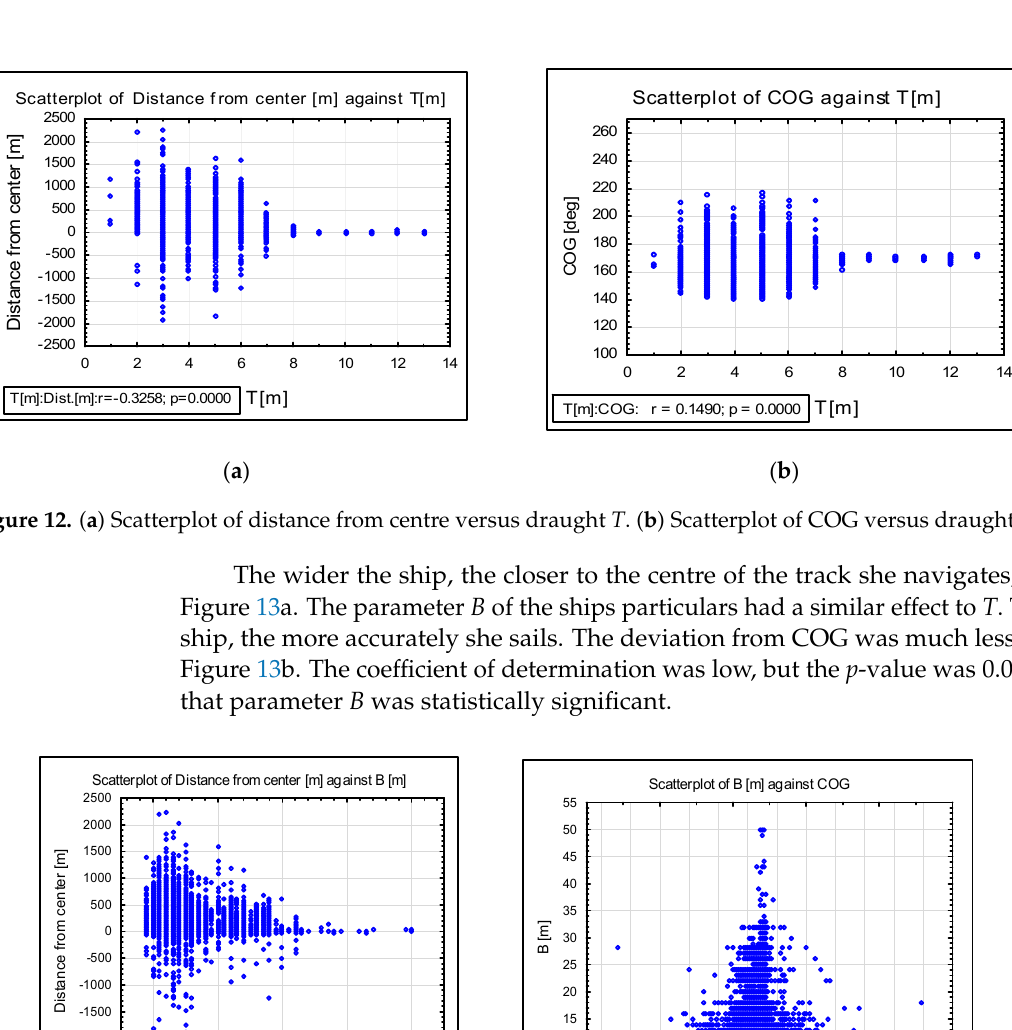
( b ) Figure 11. ( a ) Mean versus distance to 10 m isobaths D 10m , R 2 = 0.63, p = 0.0183, F = 10.3245; Standard Deviation = 292.23 + 0.0416 * distance to isobaths. ( b ) Standard deviation to distance, R 2 = 0.62, p = 0.0197, F = 9.927; Mean = 212.3691 + 0.0210 * distance to isobaths.